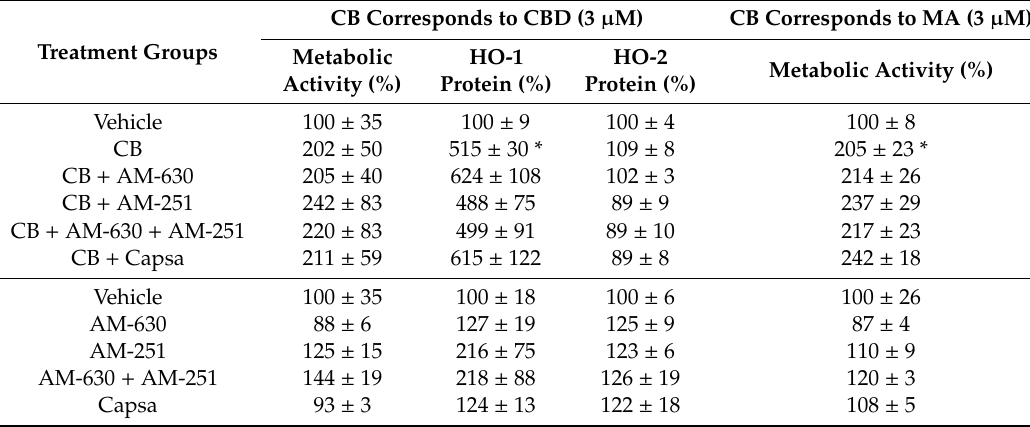
Table 1. Involvement of cannabinoid-binding receptors in the changes in metabolic activity and HO expression triggered by the cannabinoids (CB) studied. The cells were pre-treated for 1 h with AM-251 (CB 1 antagonist), AM-630 (CB 2 antagonist), or capsazepine (Capsa; TRPV1 antagonist) at 1 µ M concentrations before the examined CB (each at a 3 µ M concentration) or vehicle was added. Subsequently, the incubation was continued for 24 h. Afterwards, the cells were evaluated with respect to their metabolic activity by WST-1 assay. In the case of CBD experiments, the expression of HO-1 and HO-2 was additionally analyzed. Protein expression values were normalized to β -actin. The percentage control represents a comparison with the cells treated with vehicle (set to 100%) in the absence of test substance. The data represent mean values ± SEM of n = 4 (CBD) or n = 3 (MA) di ff erent donors. * p < 0.05 vs. vehicle control; one-way ANOVA with Bonferroni’s post hoc test. A significant e ff ect of antagonists on basal metabolic activity and HO expression (in the absence of the respective cannabinoid) was excluded by one-way ANOVA with Dunnett´s post hoc test.